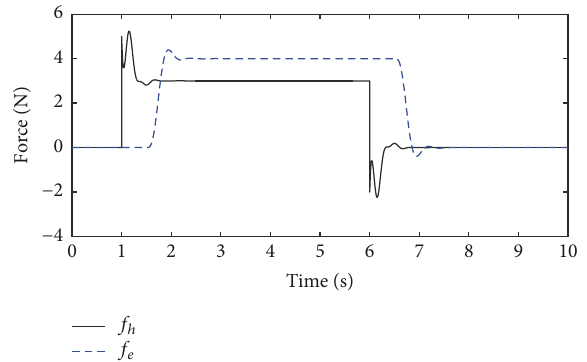
Figure 14: Force tracking performance ( 𝑇 1 = 0.5 s ,𝑇 2 = 2 s).